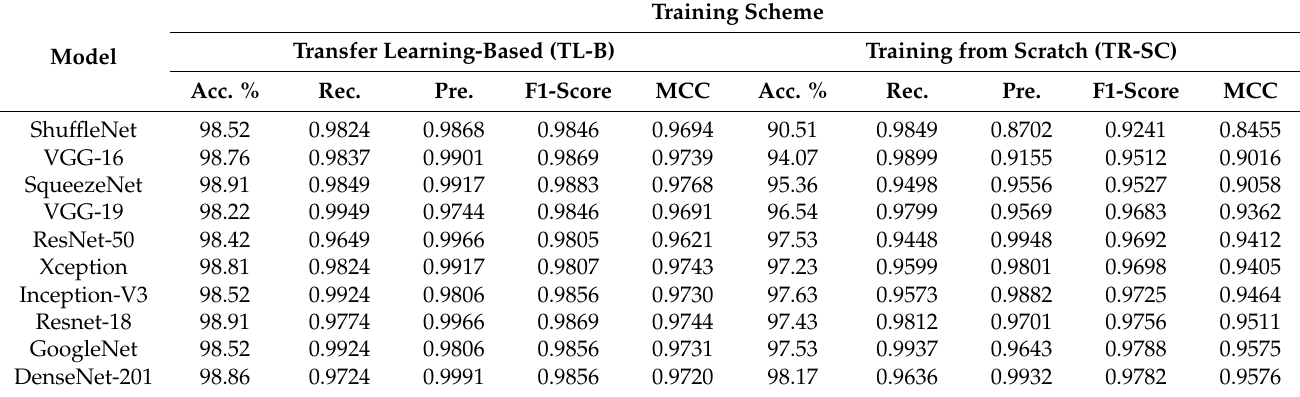
Table 3. Softmax probabilistic-based employment of custom-made CNN models 60:40% data portion- ing (training: testing).